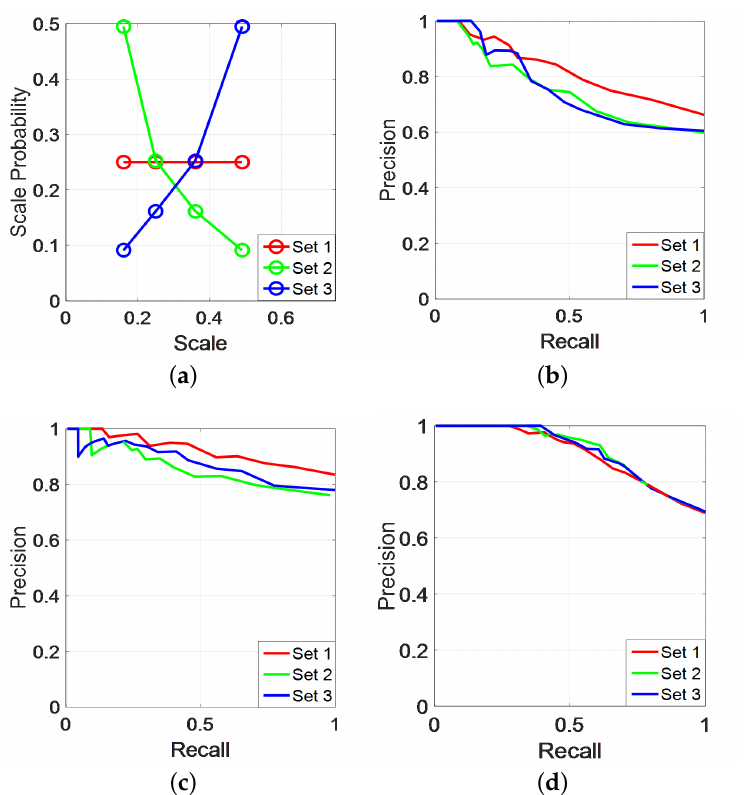
Figure 7. ( a ) Three representative scale distributions of landmarks. Set 1 shows uniform distributions, while Set 2 and 3 are non-uniform. Results of three settings on: ( b ) Mapillary Berlin; ( c ) Gardens Point Campus dataset including large viewpoint changes; and ( d ) Freiburg Across Seasons dataset with slight viewpoint